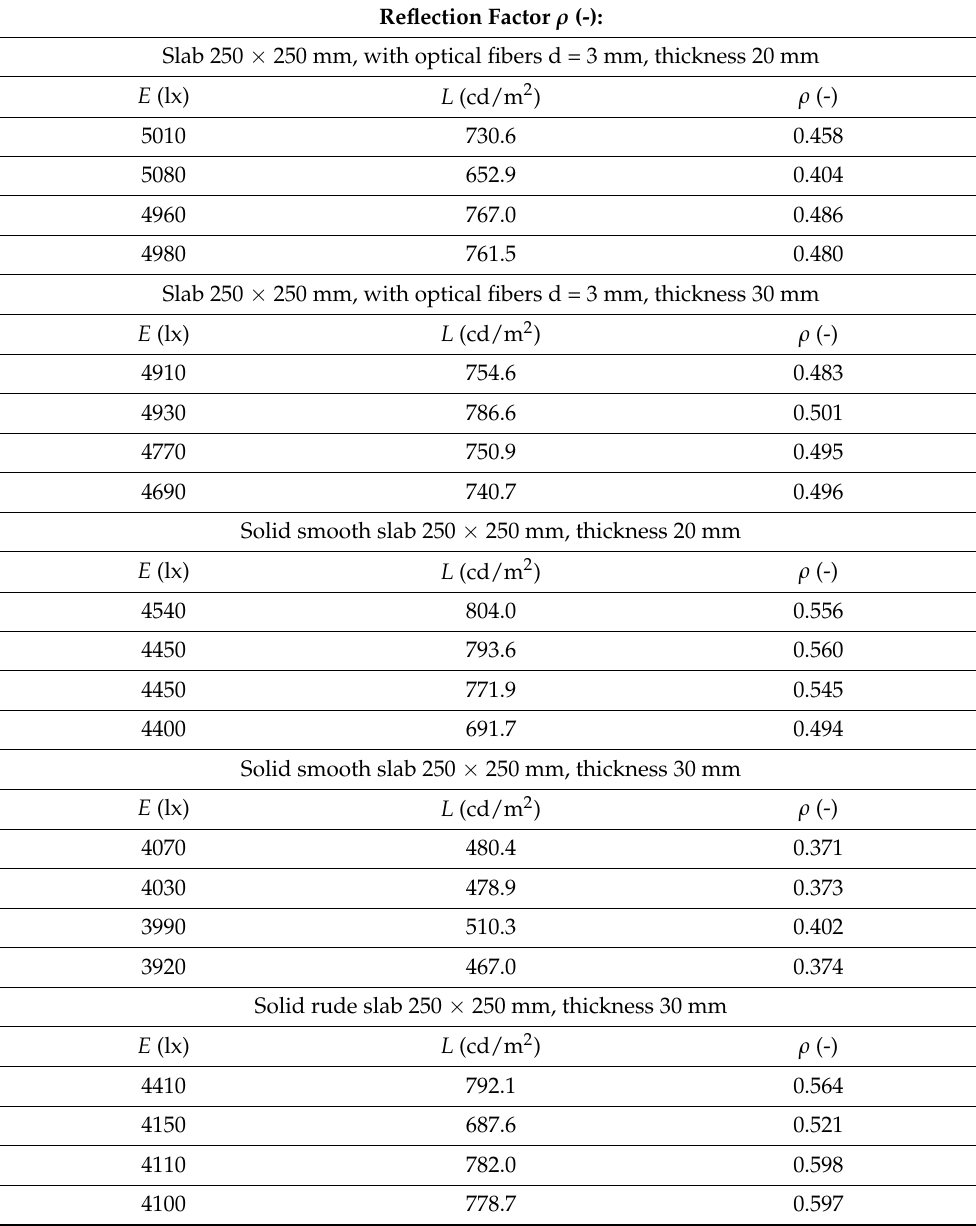
Table 7. Reflection factor ρ